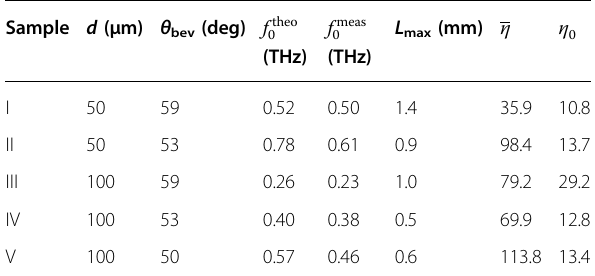
Fig. 2 THz data and buildup plots for sample III. a Space-time plot of raw data. b Dispersion plot obtained by 2D Fourier transform of data in ( a ). Calculated dispersion curves for TE 0 , TE 1 and TE 2 dielectric waveguide modes are shown by the dashed curves. White arrows indicate spectral modulations caused by backward-propagating THz waves. c Surface plot of THz buildup. d 2D plot of THz buildup with selected probe positions shown. Reference shown in black Table 1 Enhancement values and buildup center